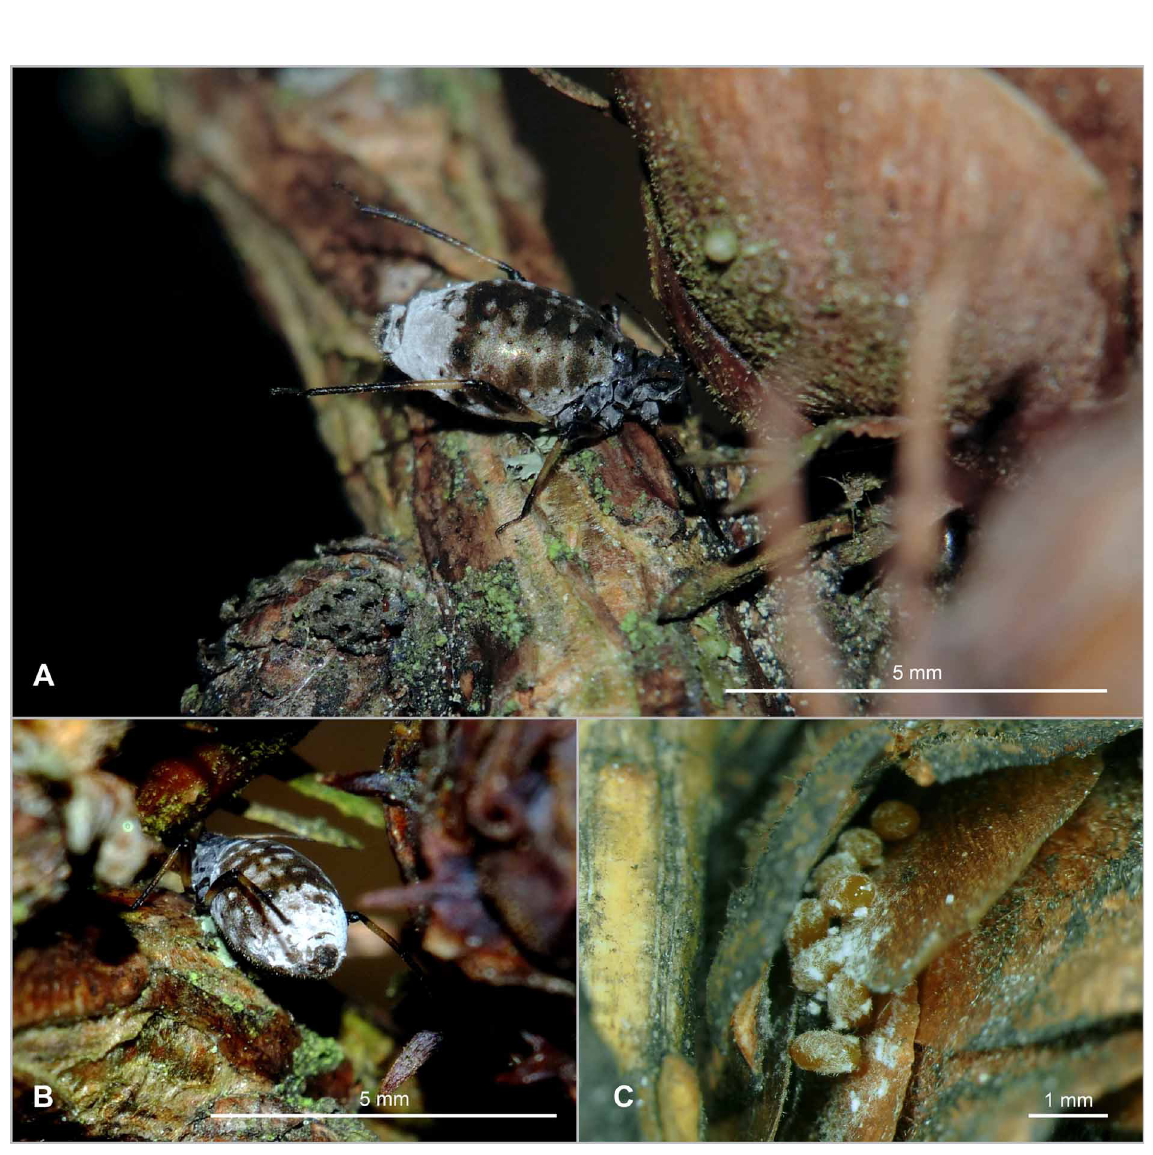
Fig. 68. Cinara (Cinara) cuneomaculata (del Guercio, 1909) on Larix decidua in late autumn. A–B . Oviparae on old twigs and cones. C . Eggs between scales of old cone. Note the preanal wax ring of the oviparae and the wax powder on the eggs.